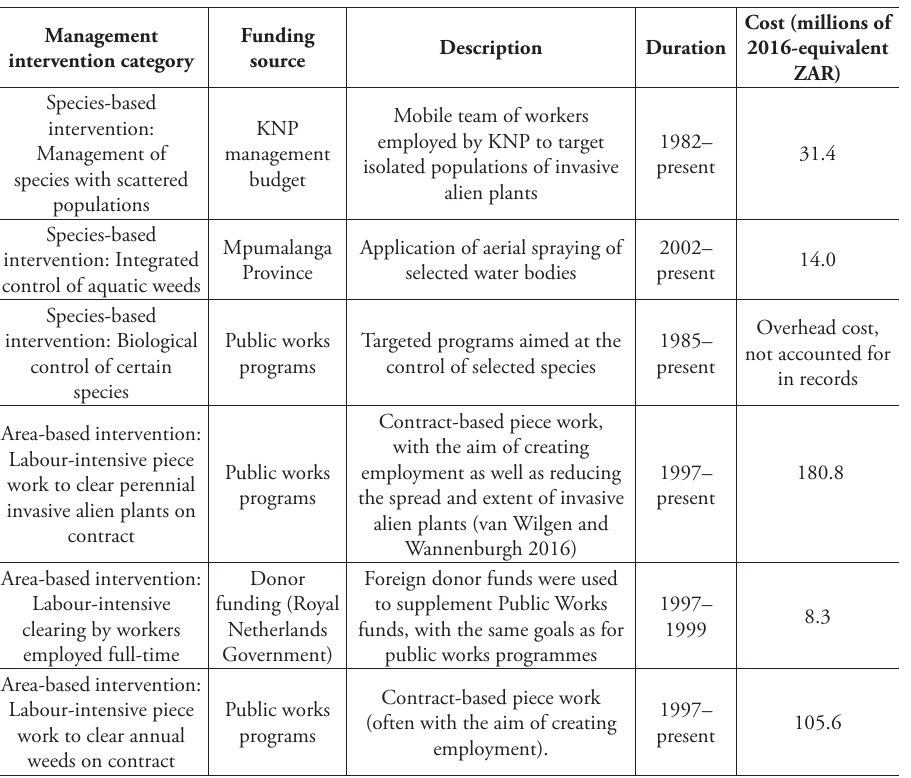
Table 2. Funding for alien plant management in the Kruger National Park. Funding sources and costs (1997–2016) are associated with five management intervention categories aimed at the control of alien plants in the Kruger National